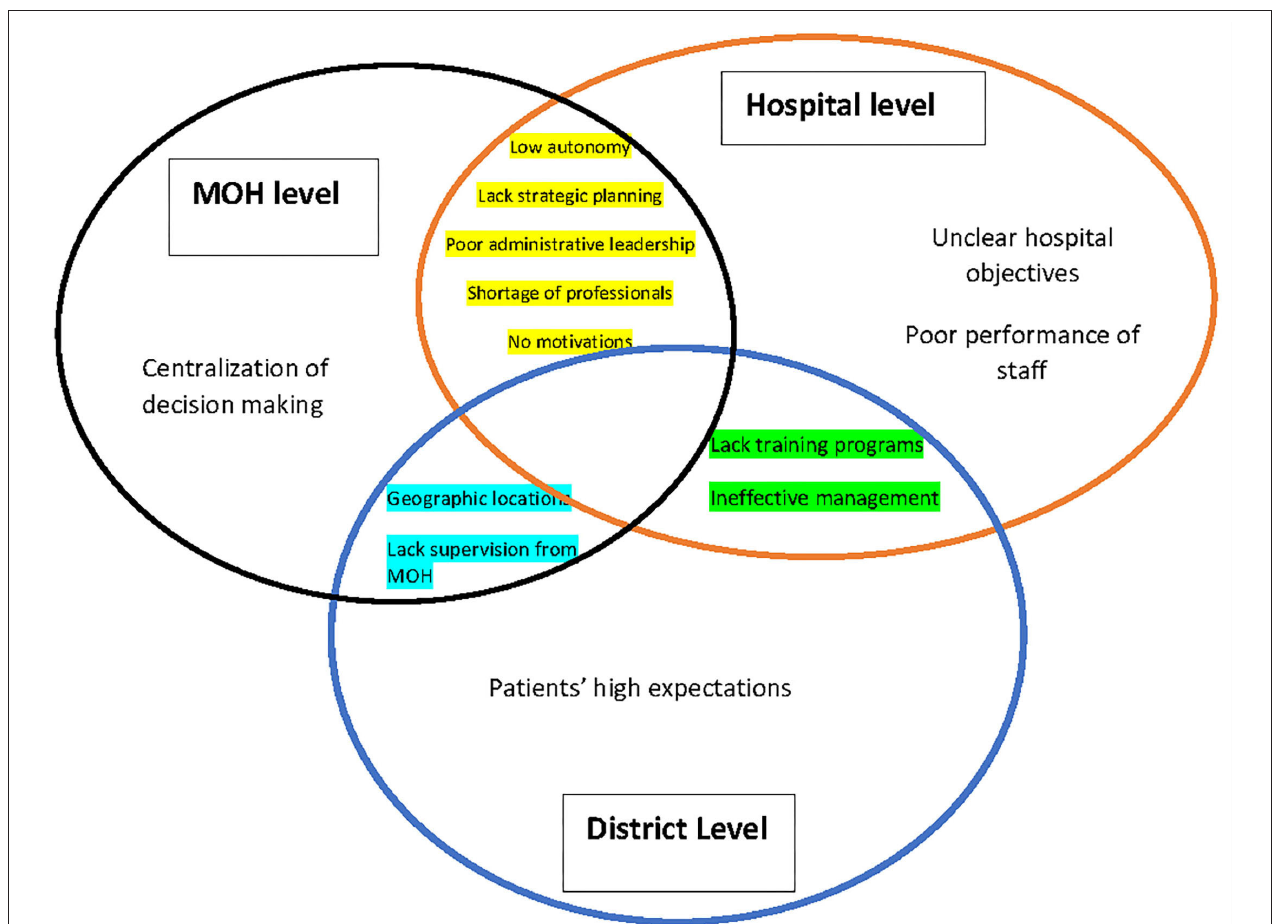
FIGURE 1 | Summery of barriers of efficiency and utilization of health resources in public